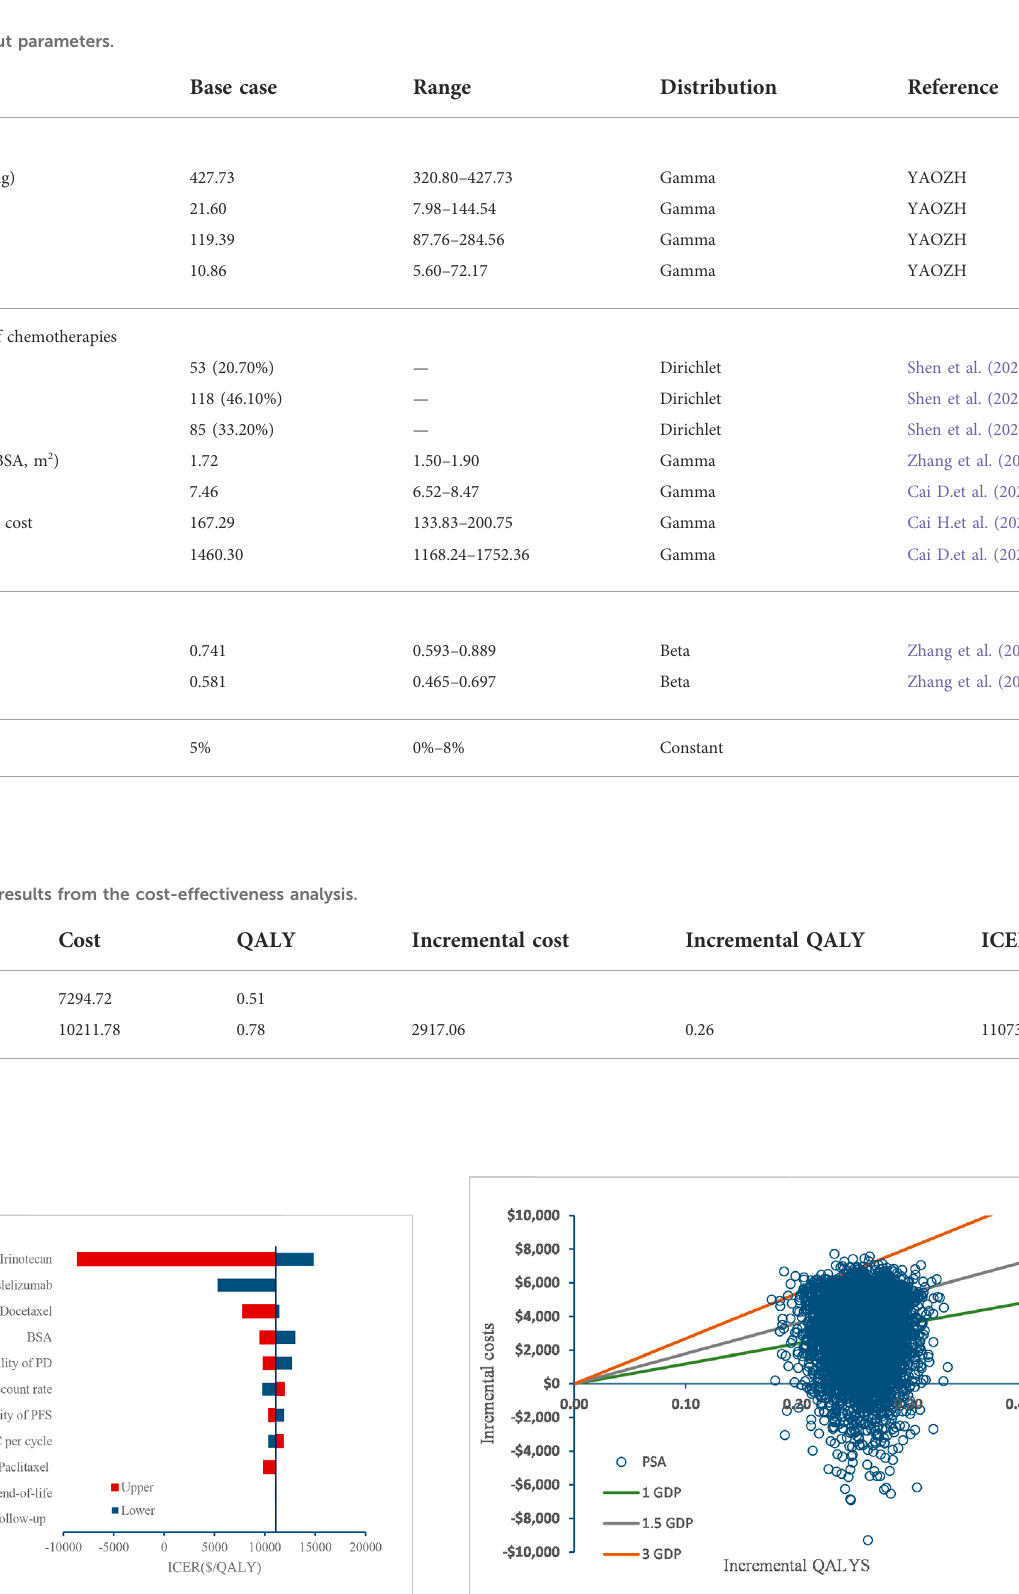
FIGURE 3 Scatter